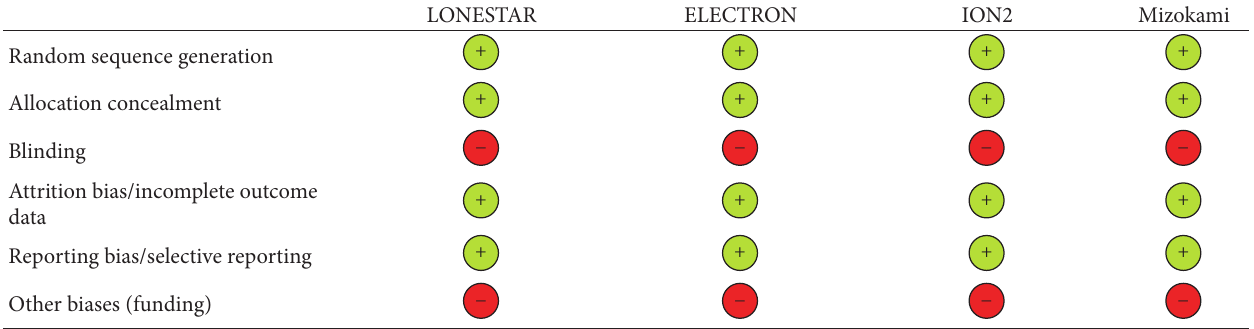
Table 2: Cochrane Risk of Bias Assessment for included